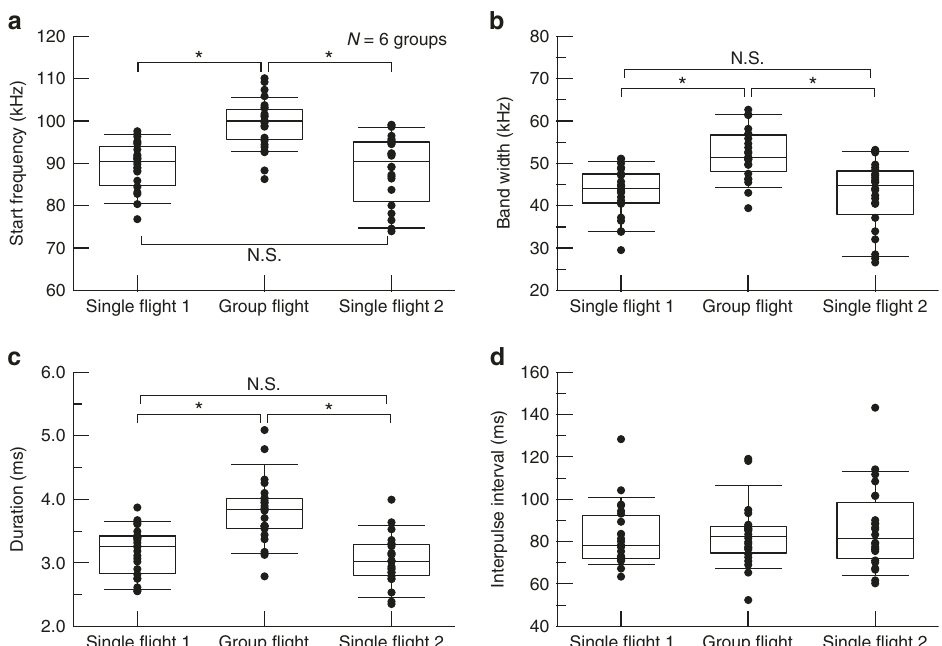
Fig. 3 Means of the acoustic characteristics emitted by each bat in single fl ights 1 and 2 and group fl ight for all groups. a Changes in Fs. b Changes in duration. c Changes in bandwidth. d Changes in interpulse interval. We obtained 24 data points per fl ight condition. Horizontal lines inside boxes show medians. The upper and lower bounds of the boxes show fi rst and third quartile, respectively. The horizontal bars above and below the boxes show the 10th and 90th percentiles, respectively. Fs, bandwidth, and duration were signi fi cantly increased from single fl ights 1 and 2 to group fl ight (Tukey ’ s HSD test, P < 0.05). On the other hand, IPIs did not signi fi cantly differ among fl ight conditions (one-way ANOVA, P = colored lines on the trajectories shown in Fig. 1a. The pulses of other bats fl ying nearby were occasionally recorded by the Tele- mikes (white triangles in Fig. 1b). We examined how the bats